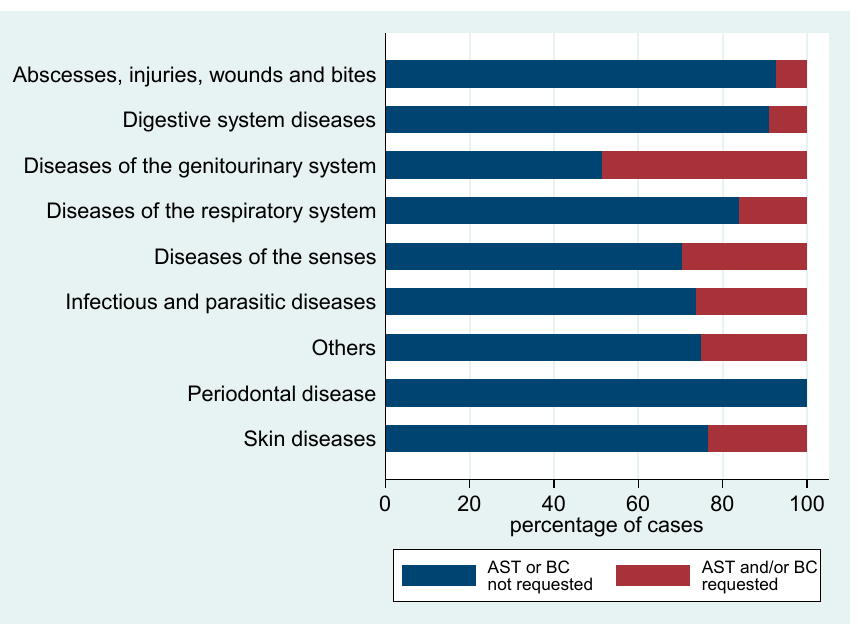
Figure 4. Use of laboratory diagnostic tests for diseases reported and treated by respondents ( n = 740).